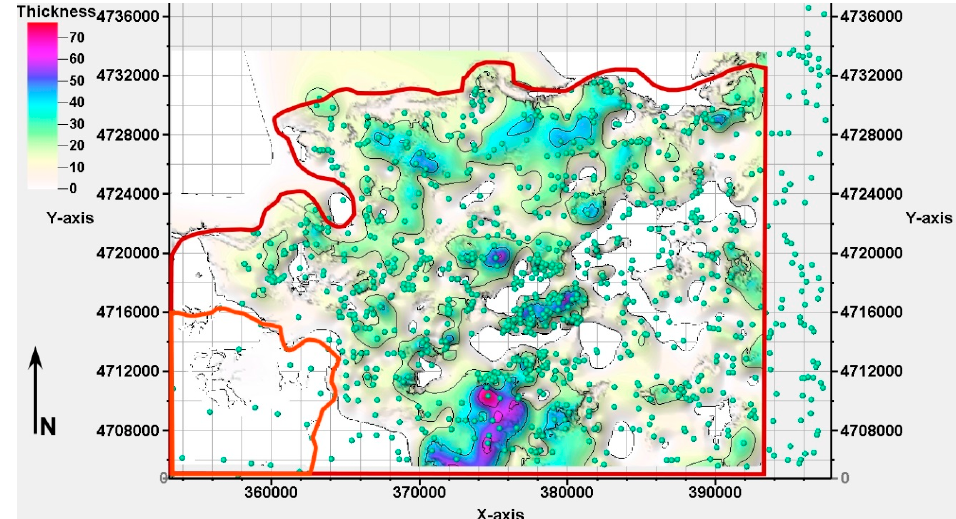
Figure 9. Isopach map of the Tiskilwa Formation in the study area, which is outlined in red. The orange outlines where the Winnebago Formation occurs at land surface. Green dots represent the locations of water well data. Thickness is in meters.